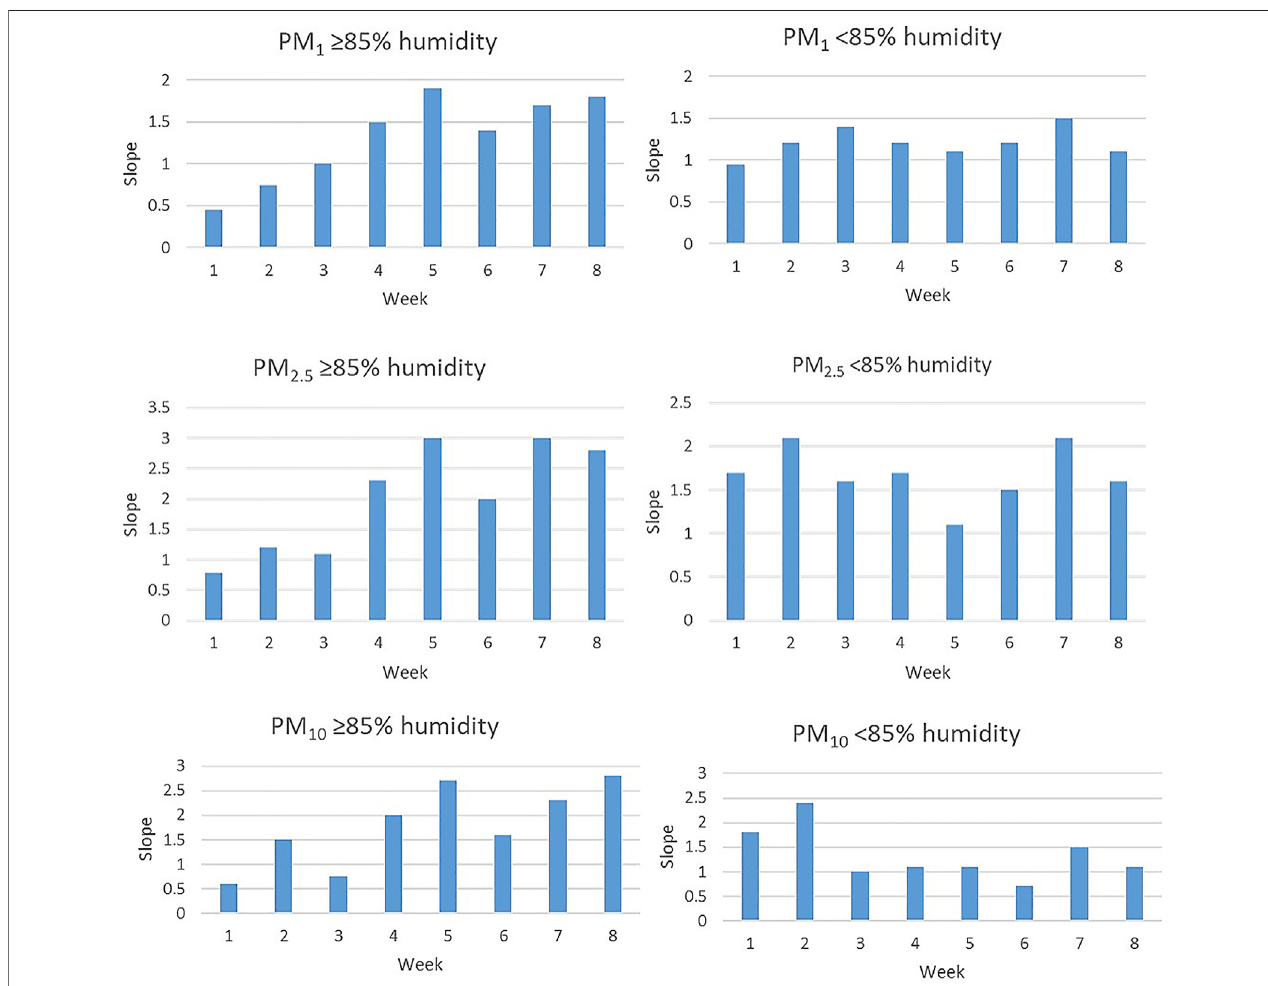
FIGURE 7 | Slope of low-cost sensor PM concentrations vs . FIDAS by week, separated by readings that occurred when the sensor recorded < 85% humidity and ≥ 85% humidity for sensor B.